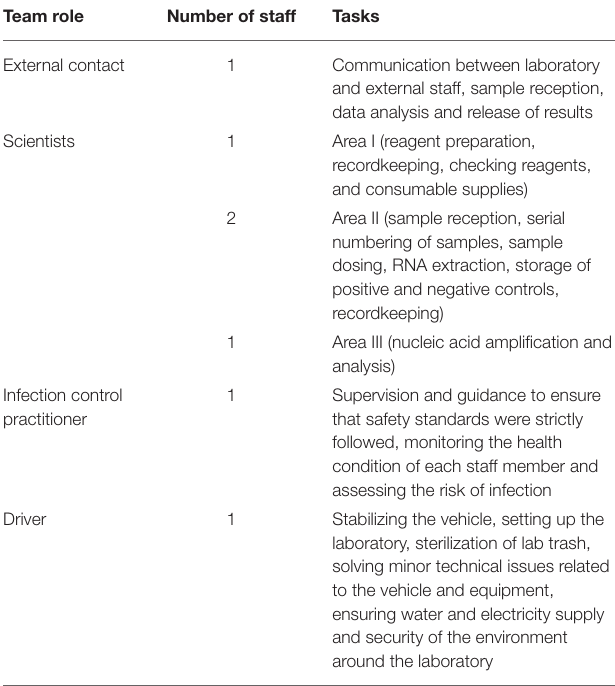
TABLE 2 | Overview of the mobile biosafety laboratory diagnostic team and tasks. Team